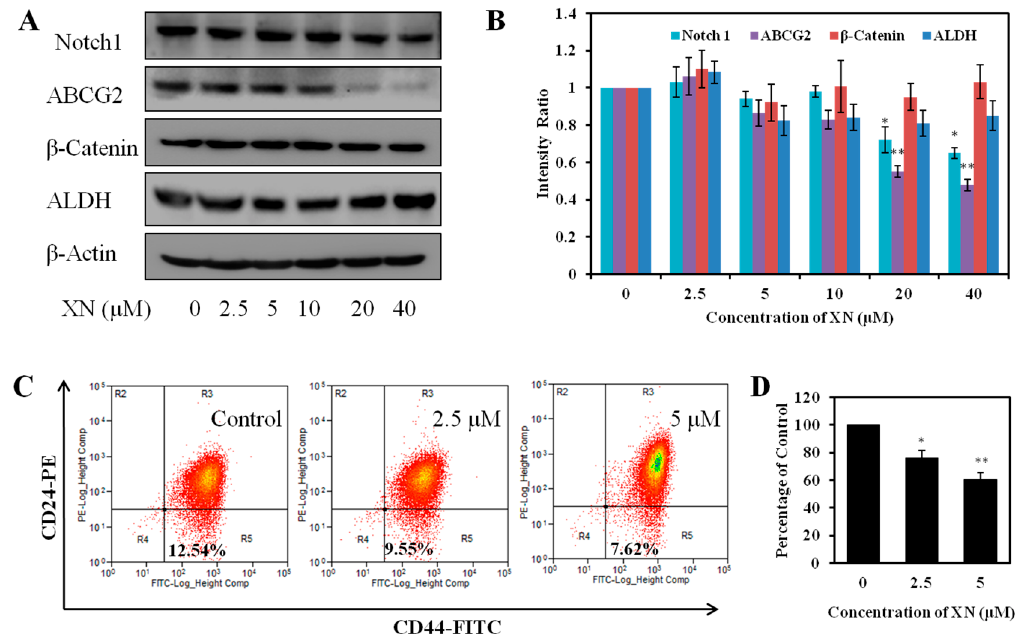
Figure 6. XN decreases the cancer stem-like cell markers of MCF-7/ADR. ( A ) XN regulates the expression of cancer stem-like cell markers. The biomarkers related to the stemness in MCF-7/ADR cells were measured by western blotting after treated with XN for 48 h; ( B ) protein levels quantified by scanning densitometry and normalized to control. Results are expressed as a ratio of control. Data represent means ± SD from three independent experiments. * p < 0.05, ** p < 0.01 for control cells versus XN treated cells; ( C ) XN reduces the percentage of CD44+/CD24 − breast cancer stem-like cells. The phenotype of CD44+/CD24 − cells was measured by flow cytometry after treatment with 5 and 10 μ M XN for 48 h; ( D ) The histogram shows the decreased population of CD44+/CD24 − cells. Results are normalized to untreated cells and the data shown are the means ± SD of three experiments for each group. * p < 0.05, ** p < 0.01 versus medium control.